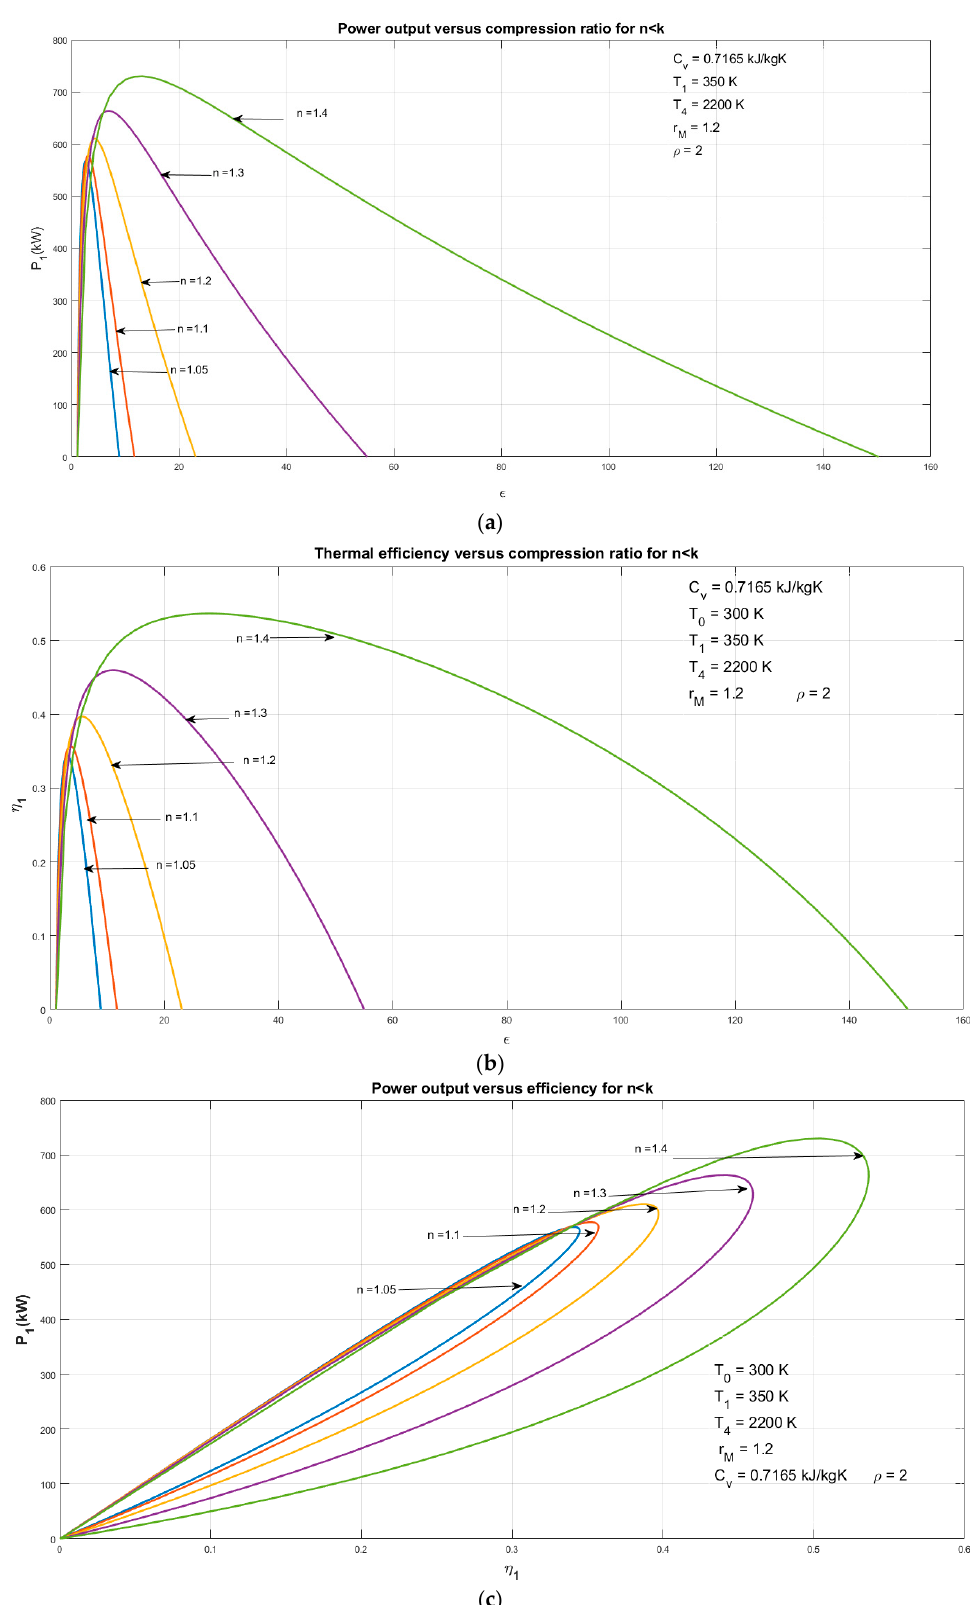
Figure 2. Impact of n ( n < k ) on P 1 – ε ( a ), η 1 – ε ( b ) and P 1 – η 1 ( c )